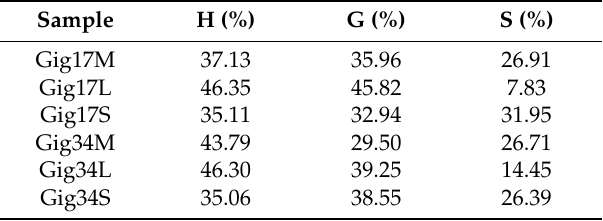
Table 7. Monolignol ratio of lignins according to pyrolysis GC/MS data of M . x giganteus samples